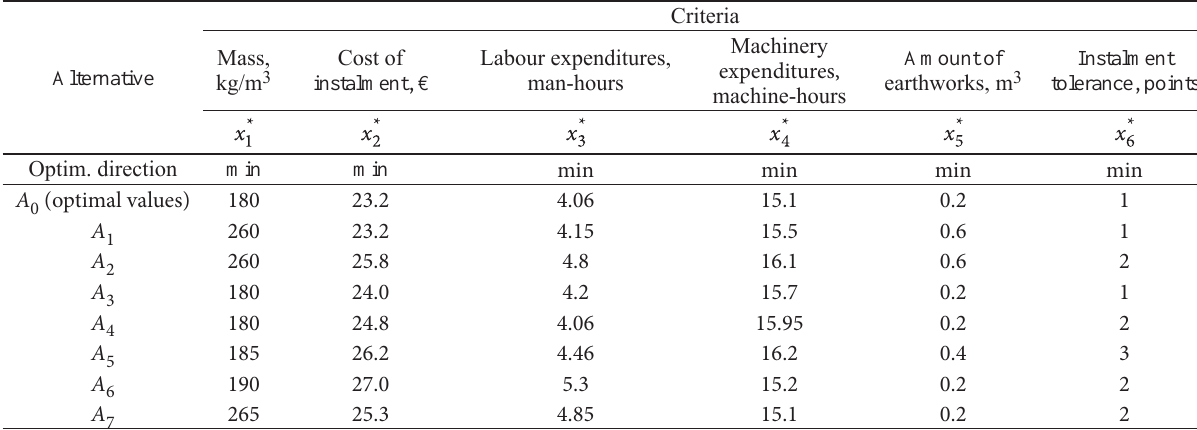
Table 1. Criteria values for evaluation – initial decision-making matrix X